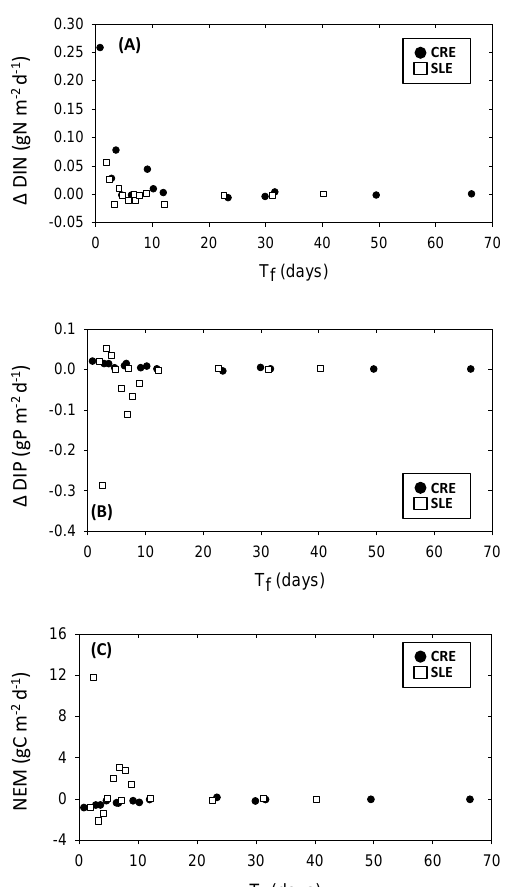
Fig. 9. Scatter plots from seasonal DIN and DIP budgets for CRE and SLE from 2002 to 2008. Estimated flushing time ( T f ; days) pro- vided the independent variable vs. (A) 1 DIN (g Nm − 2 d − 1 ) ; (B) 1 DIP (g Pm − 2 d − 1 ) ; (C) NEM (g Cm − 2 d − 1 ) .